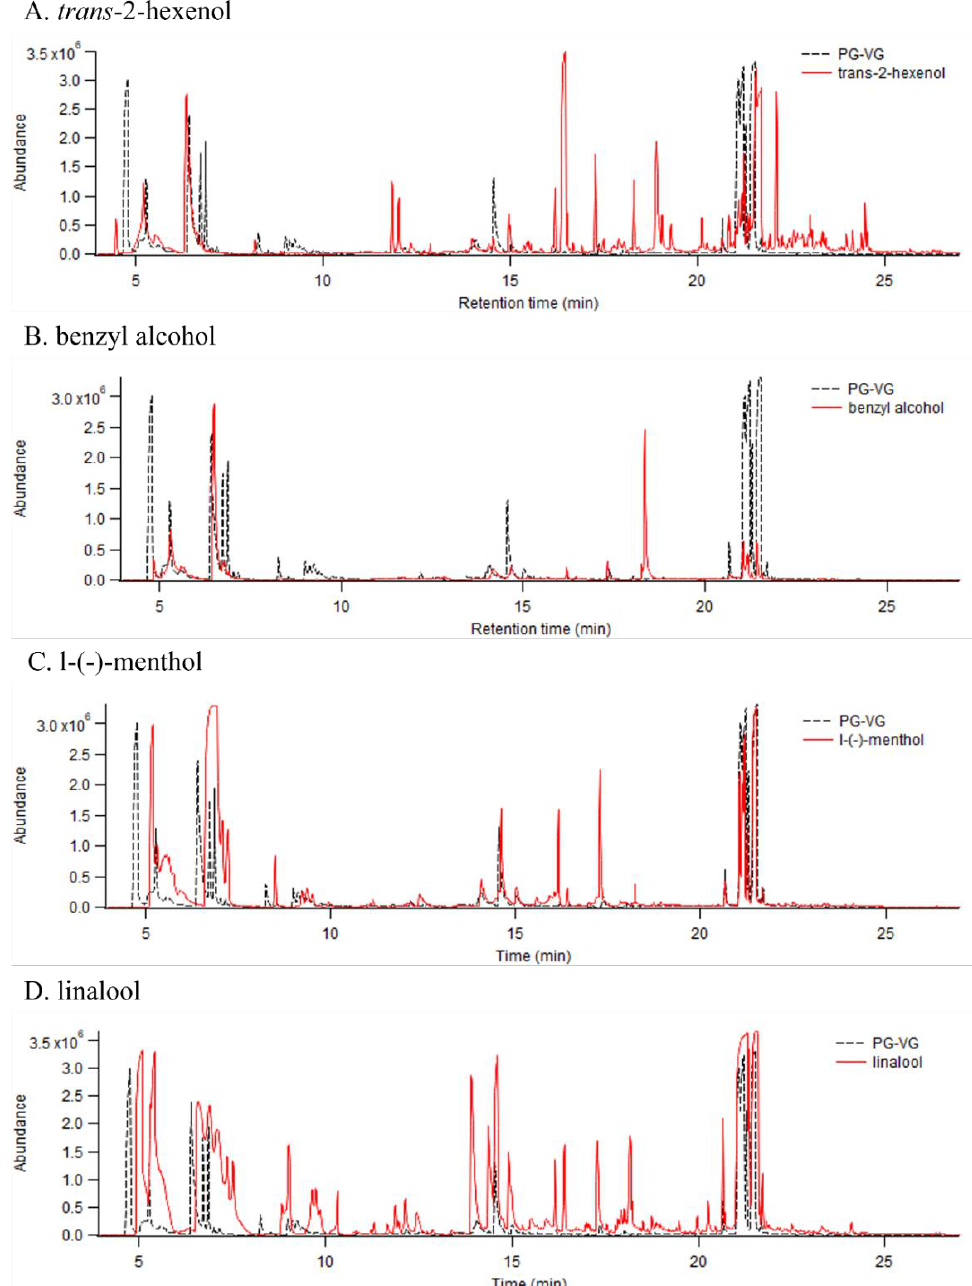
Figure 1. Extracted ion chromatographs (EICs) of m/z 181 for carbonyl-PFBHA oxime derivatives. EICs of ( A ) trans -2- hexenol, ( B ) benzyl alcohol, ( C ) l-(-)-menthol, and ( D ) linalool emissions samples were compared with PG-VG (dashed black chromatograms).